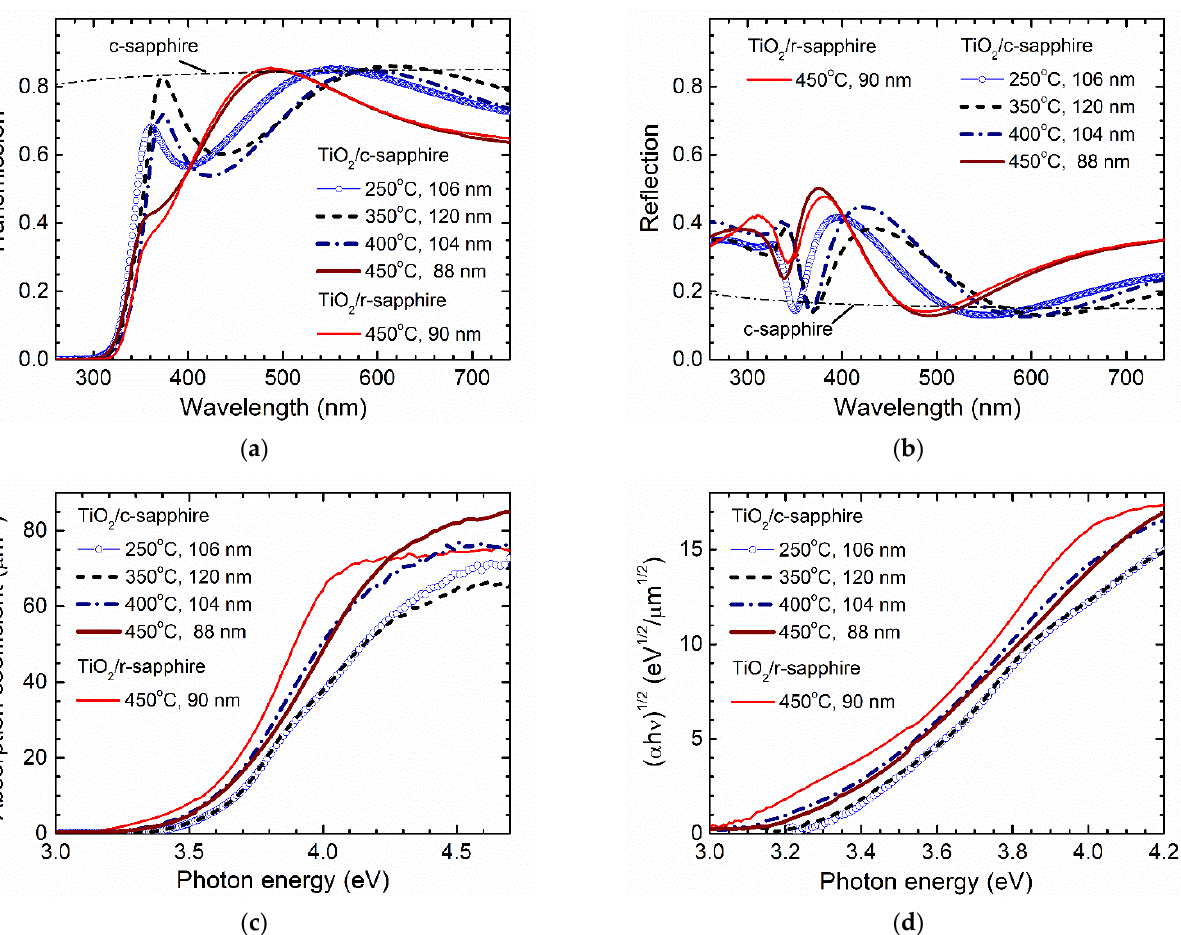
Figure 11. Optical ( a ) transmission, ( b ) reflection, and ( c ) absorption spectra, and ( d ) (α h ν) 1/2 as a function of photon energy for films grown on c- and r-sapphire. Growth temperatures and film thicknesses are shown in the figure.